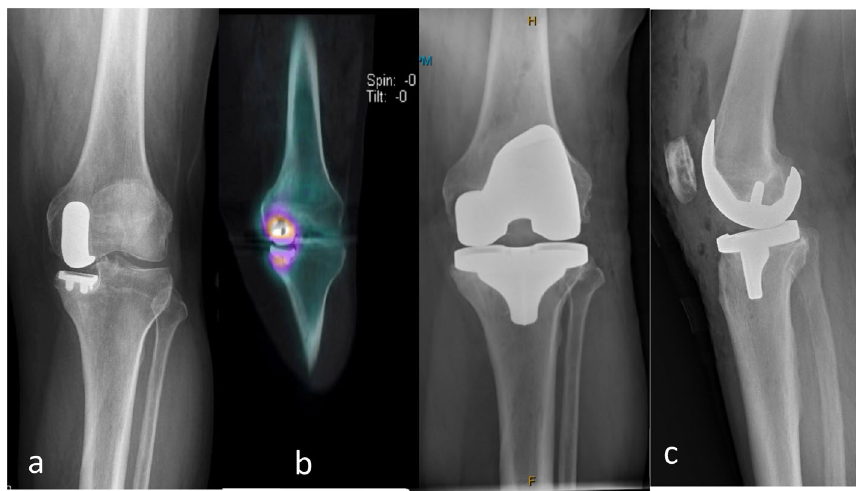
Fig. 19 a Preoperative knee radiograph of the patient with the preoperative plan from Fig. 11; b Spect CT of the knee of the same patient showing loosening of the UKA; c Postoperative knee radiograph of the same